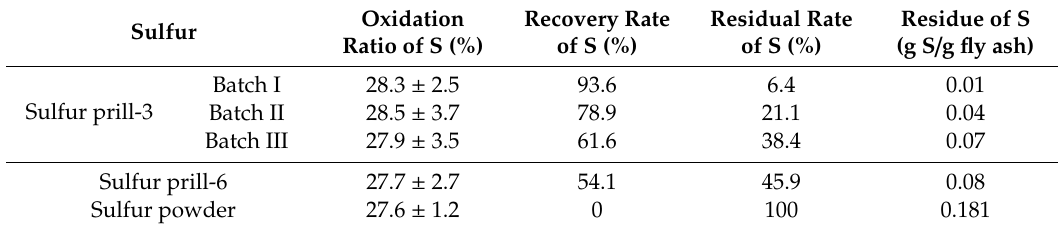
Table 1. Sulfur oxidation ration, recovery rate, residual rate, and residue of sulfur in the fly ash after